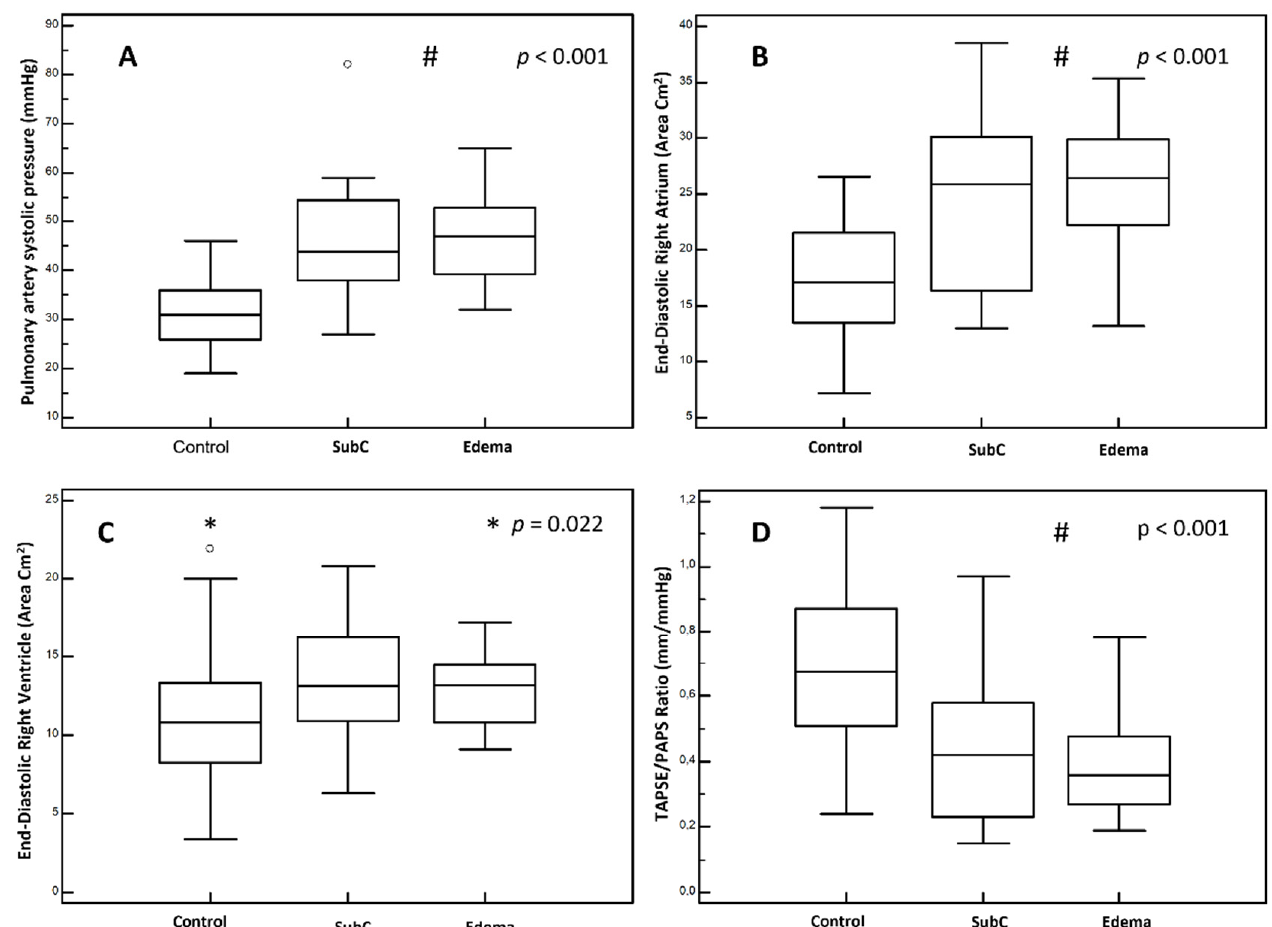
Figure 1. US findings, comparison between groups. ( A ): pulmonary artery systolic pressure. ( B ): end-diastolic right atrium area. ( C ): end-diastolic right ventricle area. ( D ): TAPSE/PAPS ratio. Group “Control”: patients without clinical signs of peripheral congestion nor echographic signs of congestion. Group “SubC” (Sub Clinical congestion): patients with echographic signs of congestion without peripheral clinical congestion. Group “Edema”: patients with peripheral congestion irrespective of echographic findings. #: p value for “SubC” and “Edema” groups vs. “Control” group. *: p value for selected groups.